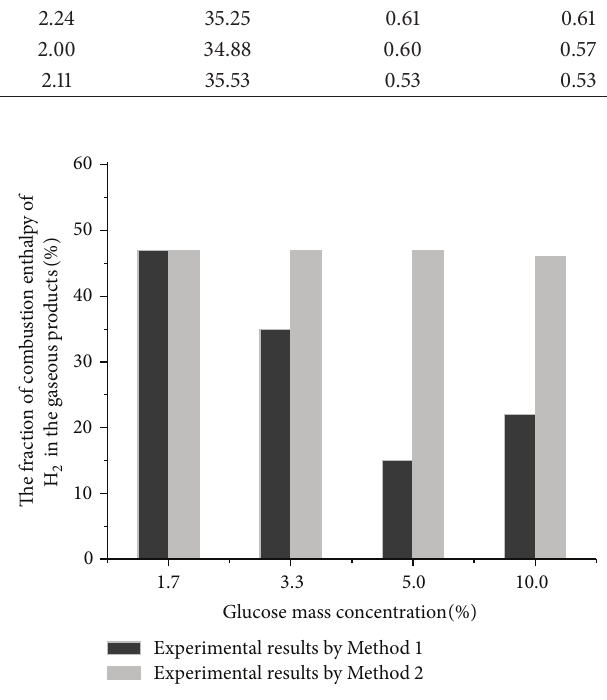
Figure 5: The variation of combustion enthalpy fraction of H 2 with the glucose concentration in the gaseous